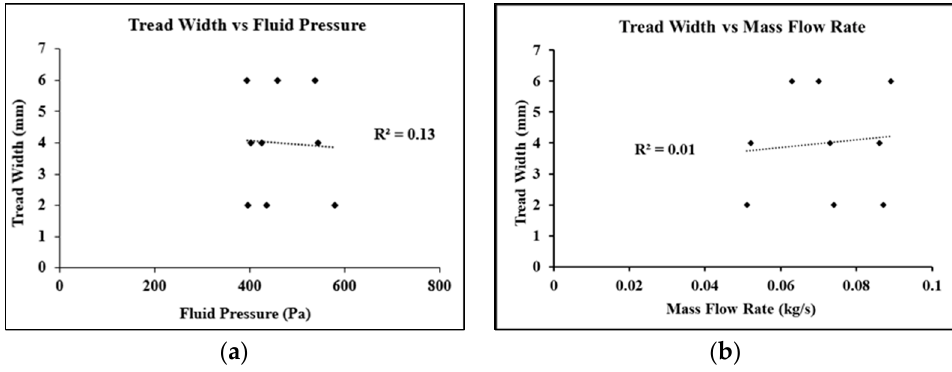
Figure 10. Effect of tread width: ( a ) induced fluid pressure and ( b ) mass flow rate.